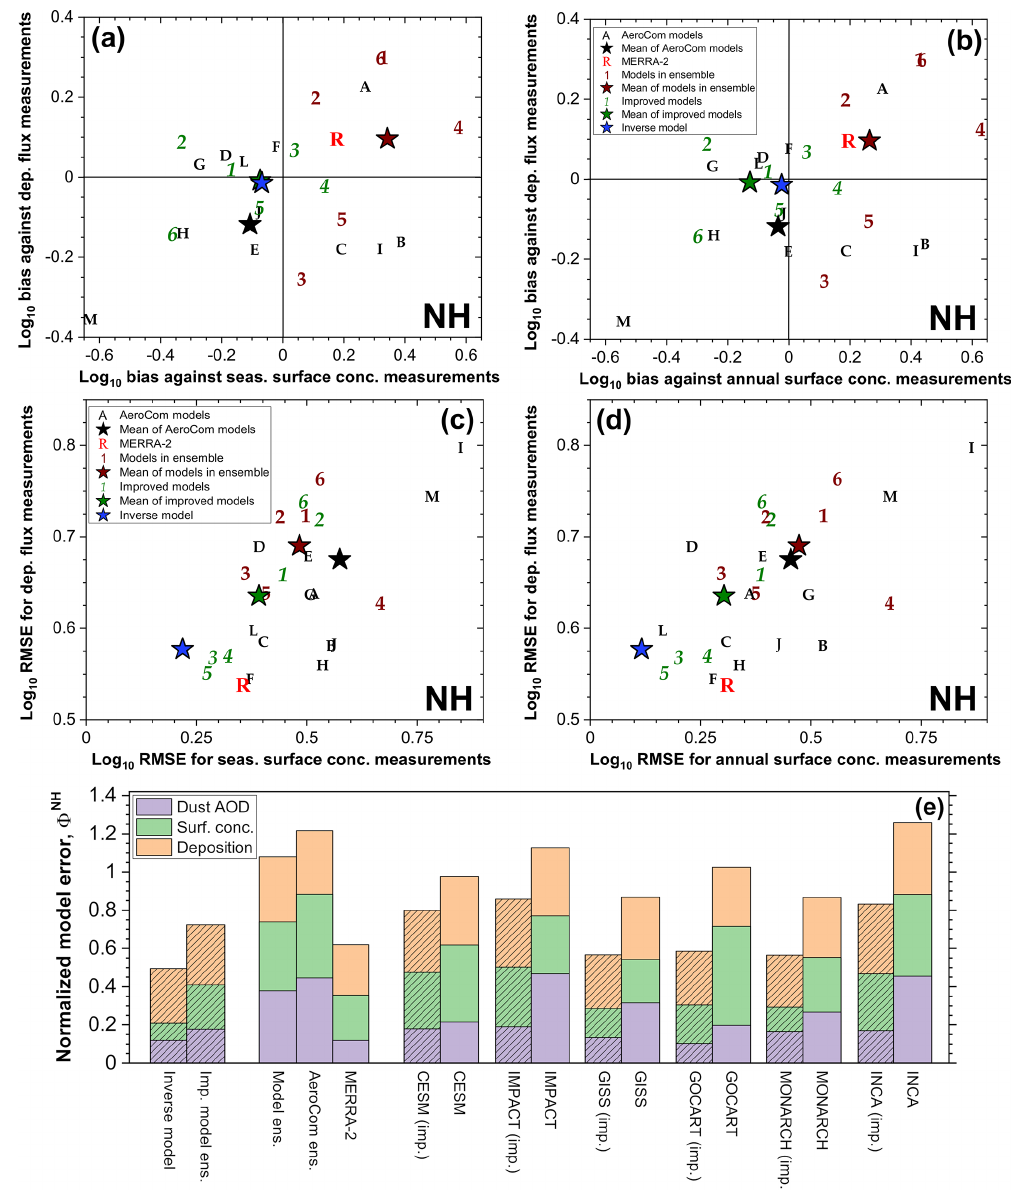
Figure 8. Evaluation of whether integrating observational constraints on dust properties and abundance produces an improved representation of the Northern Hemisphere dust cycle. Shown are the biases (a, b) and root mean square errors (RMSEs; middle panels) in logarithmic space with respect to measurements of (a, c) seasonally averaged dust surface concentration and dust deposition flux and of (b, d) annually averaged dust surface concentration and deposition flux. Symbols in panels (a) – (d) denote results for the individual models in the AeroCom ensemble (black letters), MERRA-2 (red R ), models in our ensemble (brown numbers), and the improved models (green italicized numbers). The exact legend for the different models is given in Fig. 3, and stars denote the mean bias and RMSE for AeroCom models (black star), models in our ensemble (brown star), the improved models (green star), and the inverse model results (blue star). Panel (e) shows normalized model errors (see Sect. 3.2) relative to the DAOD (purple bars), surface concentration (green bars), and deposition flux (orange bars) datasets. Shown are results for the inverse model; the average of models in the AeroCom ensemble, our model ensemble, and our ensemble of improved models; MERRA-2; and for the individual models in our ensemble before and after applying observational constraints (see Sect. 2.5). Hatched bars denote results of the inverse model and improved models obtained through our methodology. The reductions in bias, RMSE, and normalized error for the inverse model and improved models relative to the individual models and MERRA-2 imply that the integrational of observational constraints on dust properties and abundance improve the representation of the NH dust